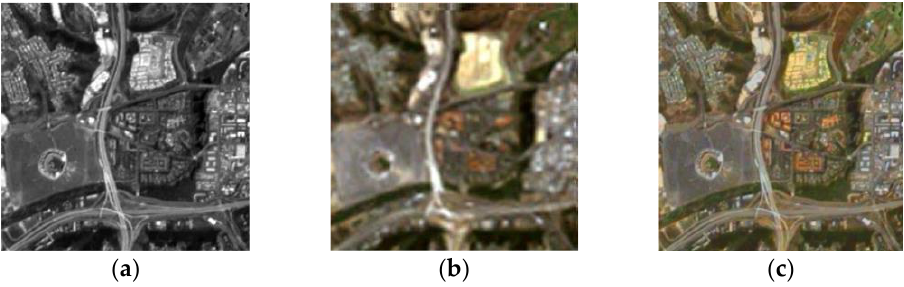
Figure 8. Image fusion in the field of agricultural remote sensing: ( a ) PAN; ( b ) MS; ( c ) fusion image.